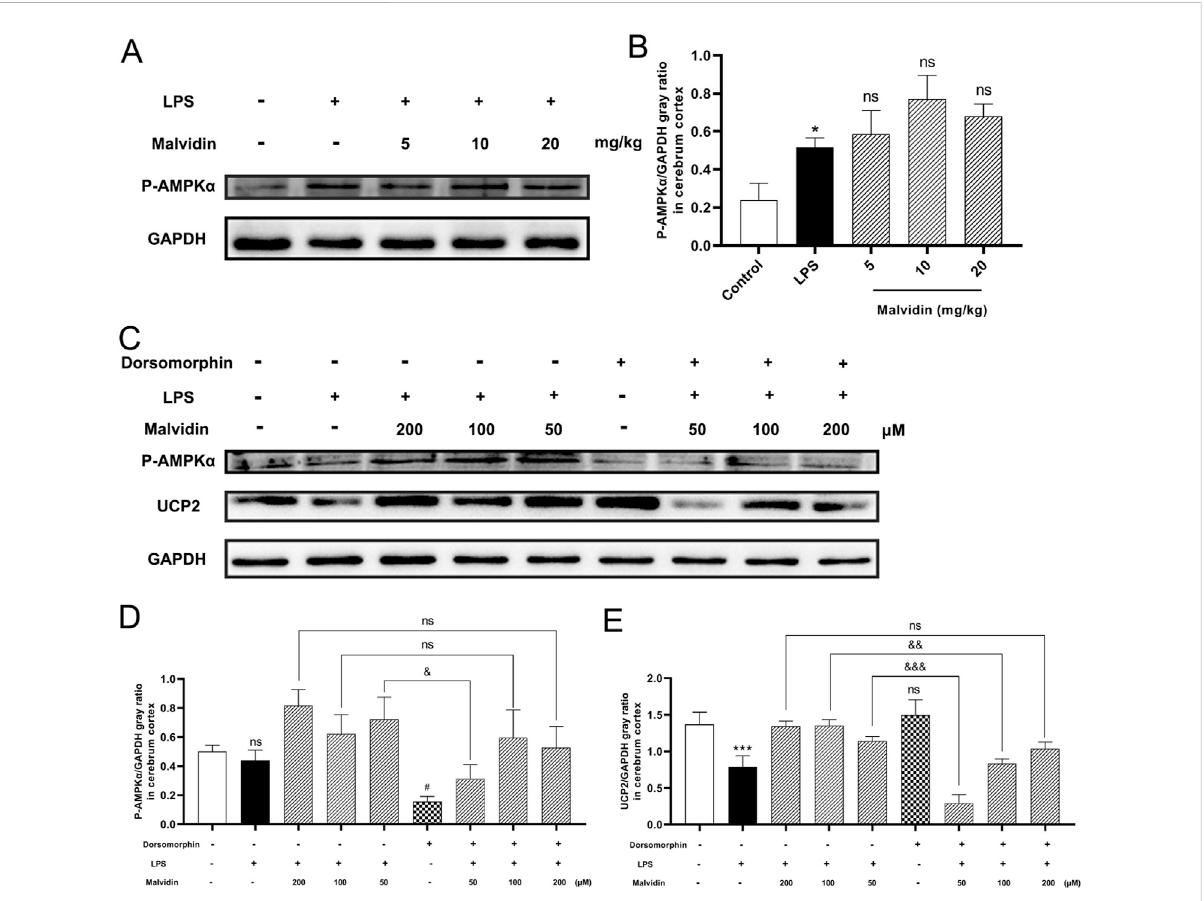
AMPK phosphorylation accelerates UCP2 protein expression in SAE models. (A) Phospho-AMPK α protein expression levels in the cerebrum tissues were detected using immunoblotting assays. GAPDH was used as an internal reference. (B) Gray ratio analysis of UCP2/GAPDH in (A) using ImageJ and excel software ( n = 3). (C) Phospho-AMPK α and UCP2 protein expression levels in BV-2 cells pretreated with or without AMPK inhibitor dorsomorphin. (D) Gray ratio analysis of Phospho-AMPK α /GAPDH in (C) ( n = 3). (E) Gray ratio analysis of UCP2/GAPDH in (C) ( n = 3). Statistical analysis was conducted using one-way ANOVA followed by Tukey ’ s post hoc testing. * represents comparison between LPS group and control group,#representscomparisonamongmalvidingroupsandLPSgroupin (B) orbetweendorsomorphingroupandcontrolgroupin (D,E)